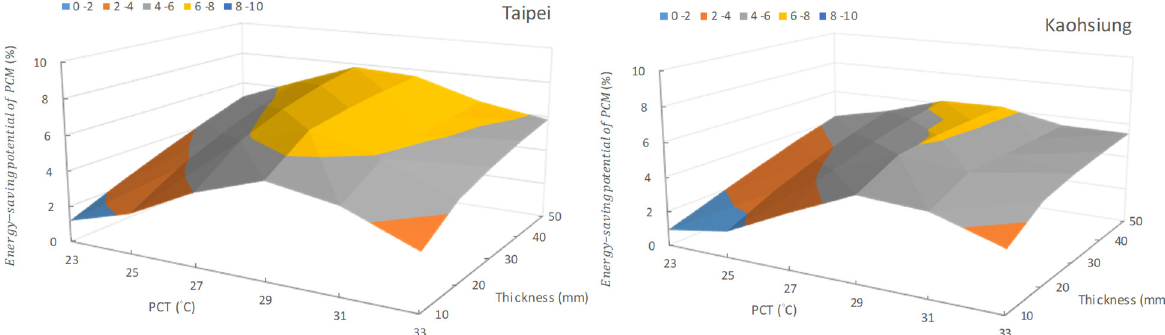
Figure 6. Energy-saving effects of different PCM roofs during the air-conditioning season from May to October.